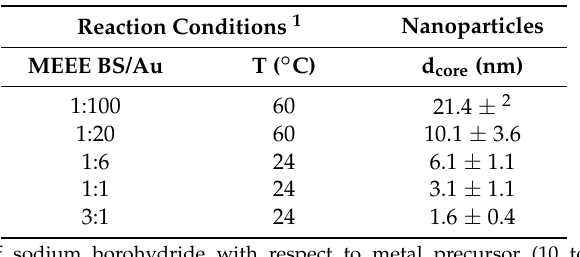
Table 1. Reaction conditions for the synthesis of AuNPs with various core sizes. Data reproduced from Ref [60],